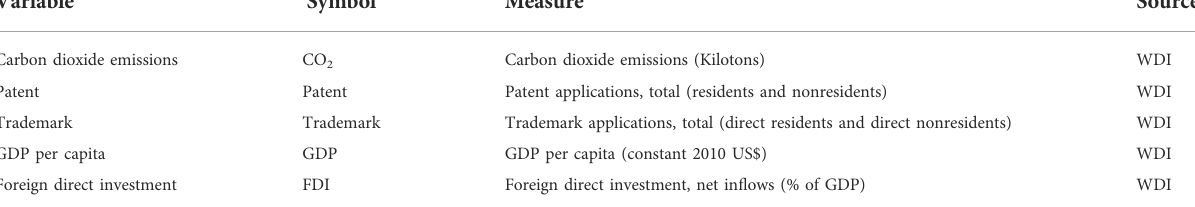
TABLE 2 Description of the variables.